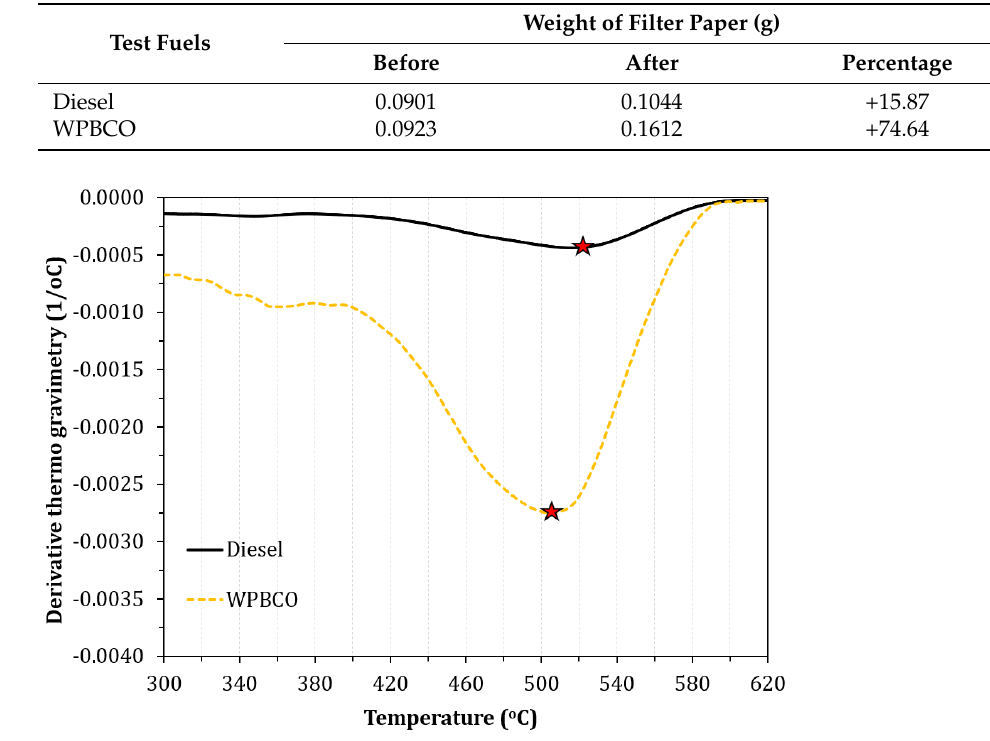
Figure 13. TGA analysis for the PM emissions of diesel fuel and WPBCO at 300 – 620 °C: red